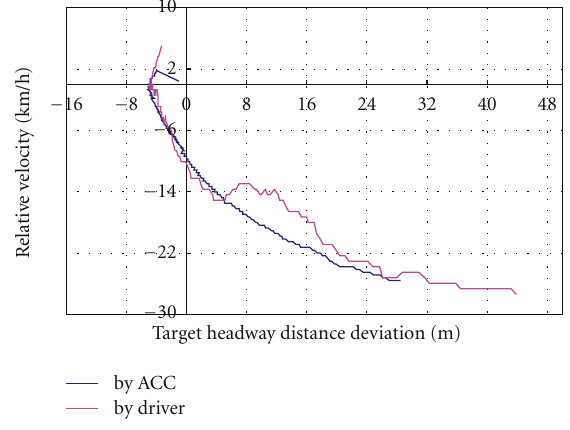
Figure 14: Results of driving